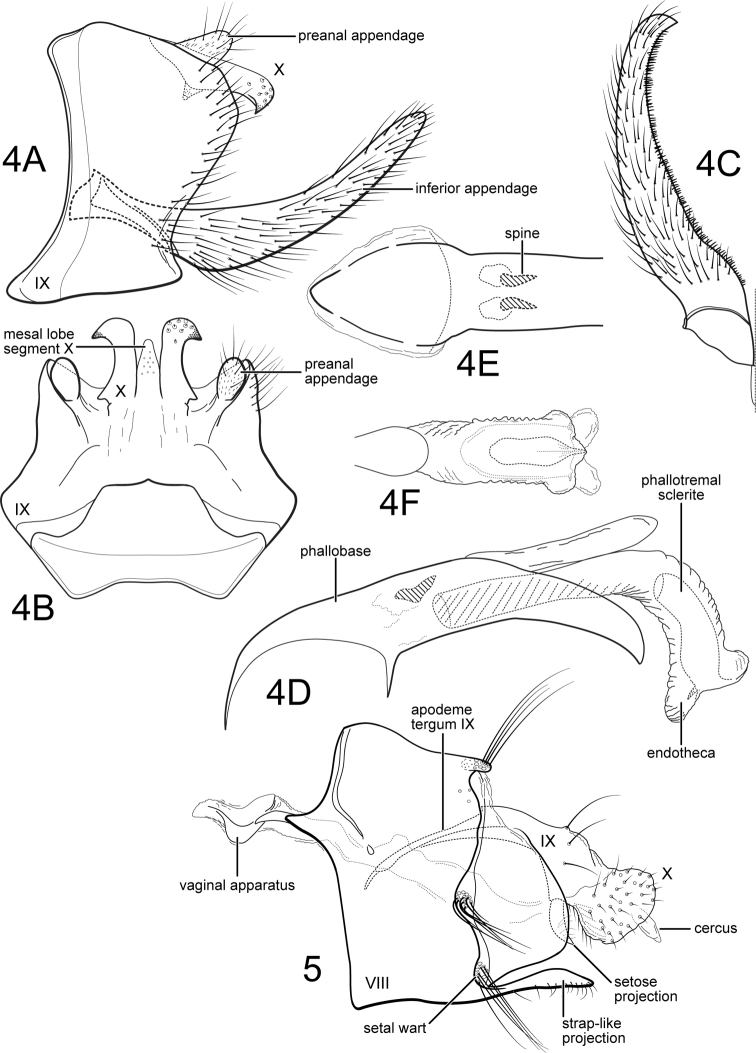
4Chimarrhodellachoco sp. n. Male genitalia A segments IX–X, lateral B segments IX–X, dorsal C inferior appendages, ventral D phallus, lateral E base of phallus, dorsal F apex of phallus, dorsal 5Chimarrhodellachoco, sp. n. Female genitalia, lateral.